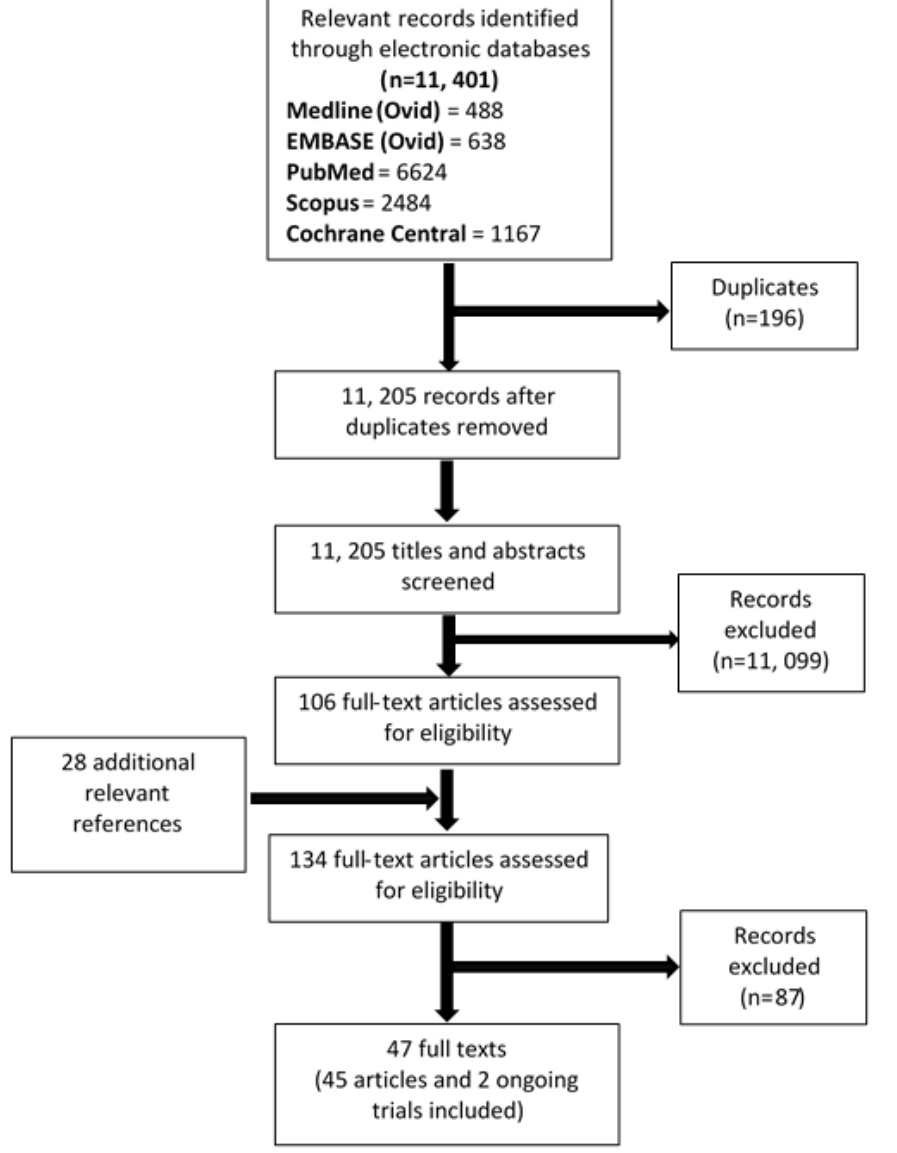
Figure 2. PRISMA flow